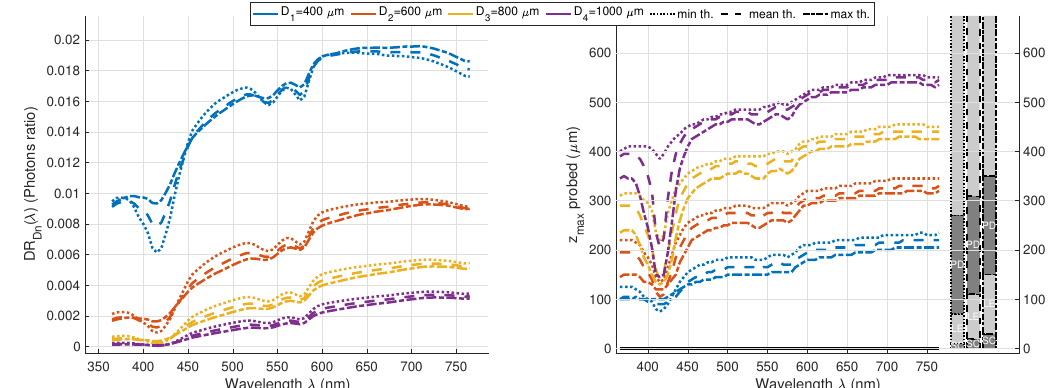
Figure 6. DR spectra ( left ) and maximum probed depth ( right ) for the thin (dotted line), mean (dashed) and thick epidermal thickness media (dashed-dot). The SD distance D n is indicated by the color code. The three right columns represent the position of the border between the layers of each skin model (thin, mean,